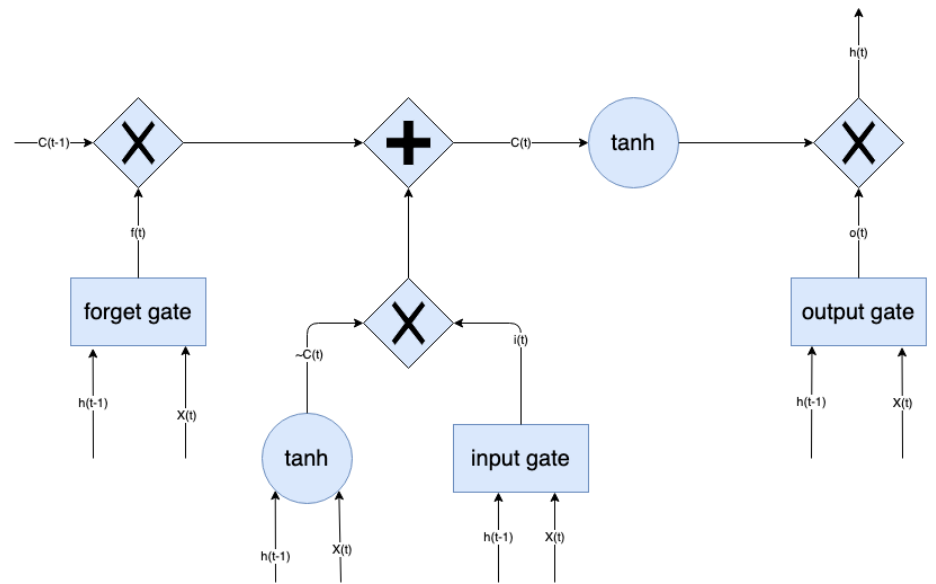
Figure 1. Scheme of a Long Short-Term Memory (LSTM)